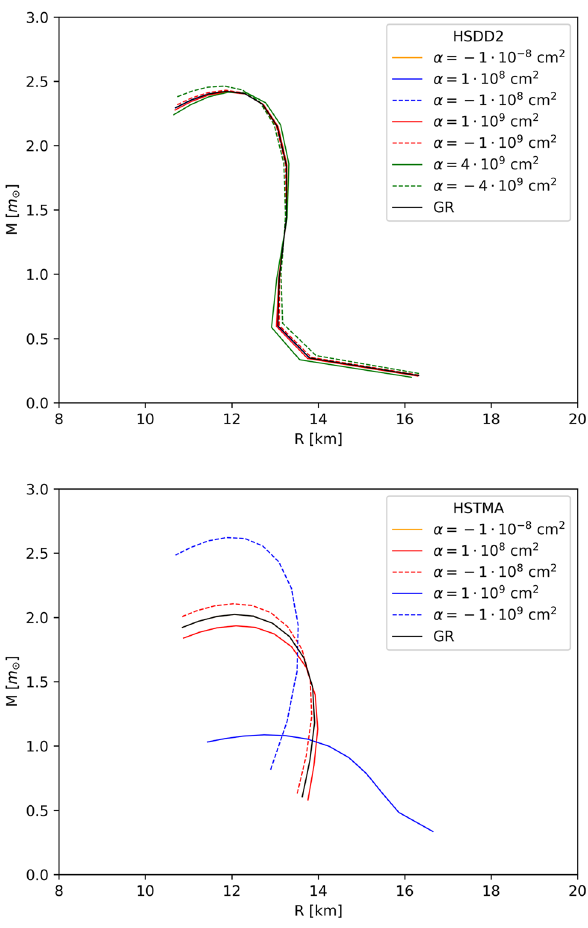
Fig. 3 Mass-radius relation for GR and f ( R ) = R + α R 2 , the HS(DD2) and HS(TMA) EoS and different values of the parameter α